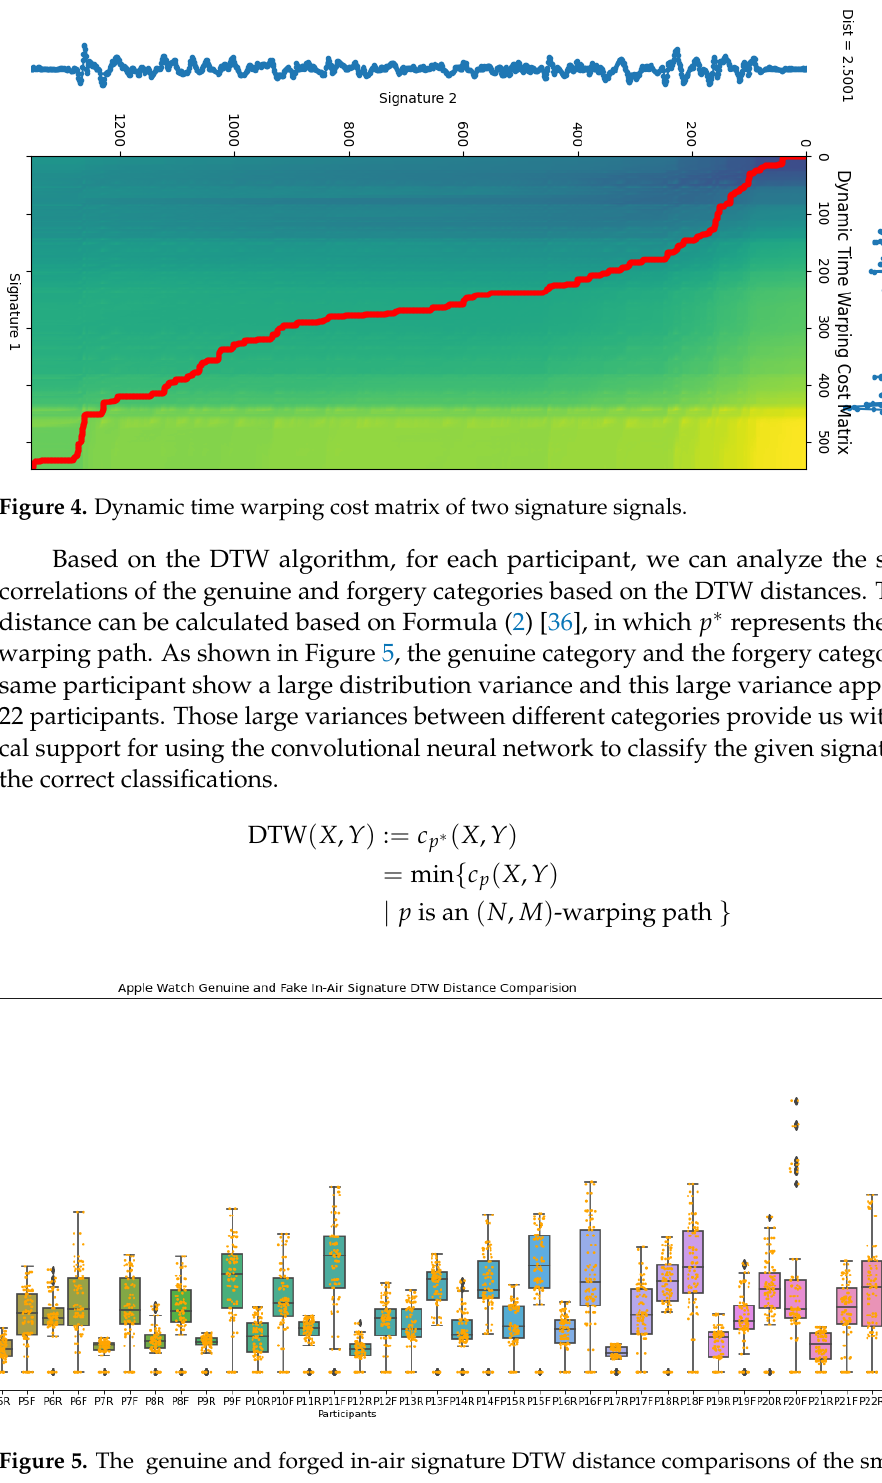
Figure 5. The genuine and forged in-air signature DTW distance comparisons of the smartwatch. PXR represents the DTW distance of the genuine signatures of participant X, and PXF represents the DTW distance of the forgery signatures of participant X. The yellow dots demonstrates the specific DTW alignment costs among the two